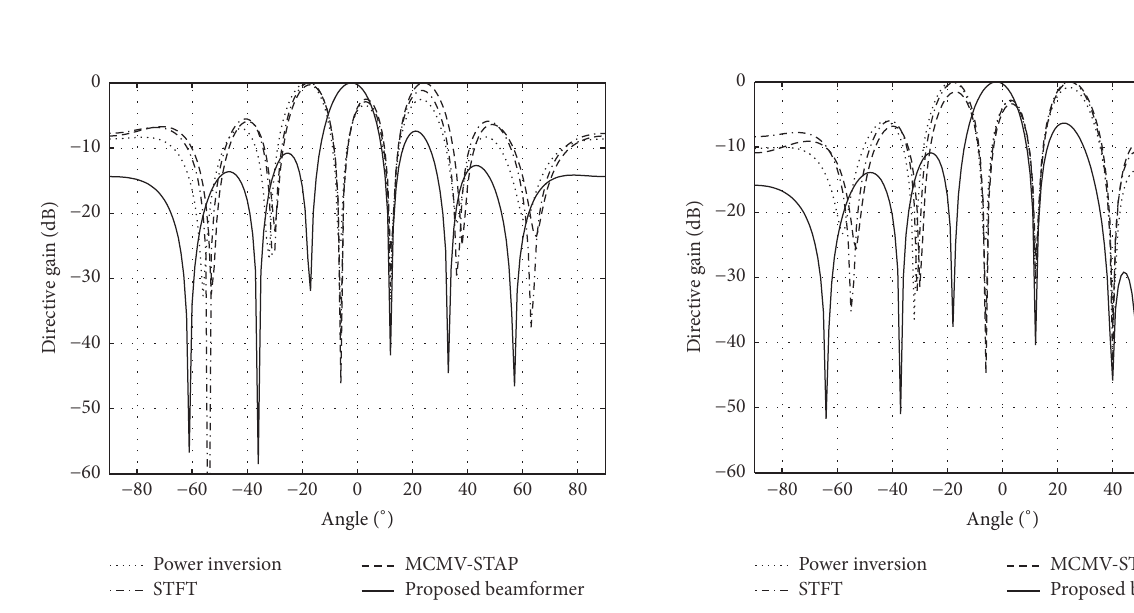
Figure 7: The array antenna pattern of antijamming for different method: the angle of arrival of the satellite signal is 0 degrees and the angles of arrival of jamming signals are − 6 degrees, 12 degrees, and 40